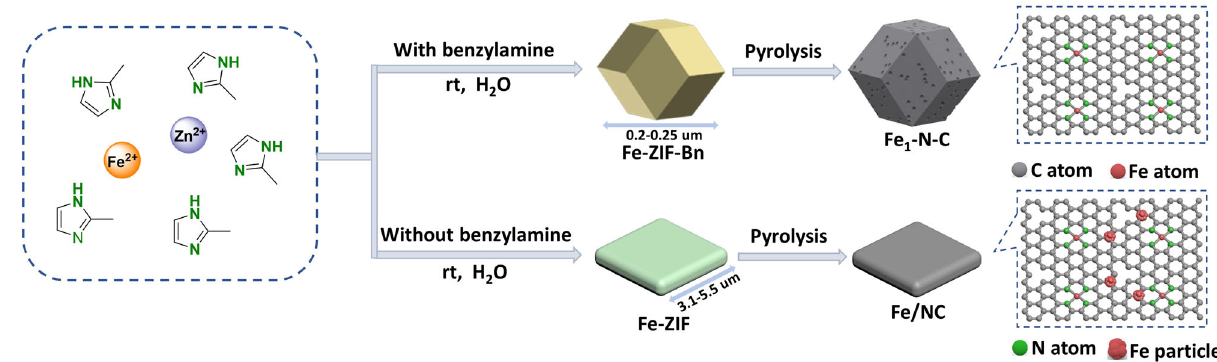
Fig. 2 Catalyst preparation process. Schematic illustration of the synthesis of Fe 1